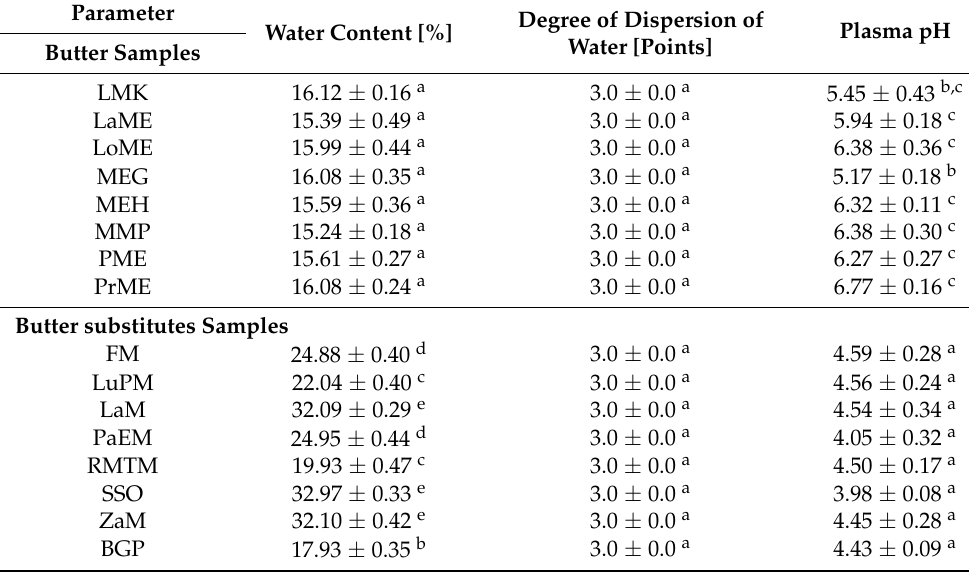
Table 5. Physicochemical properties of butter and butter substitutes.